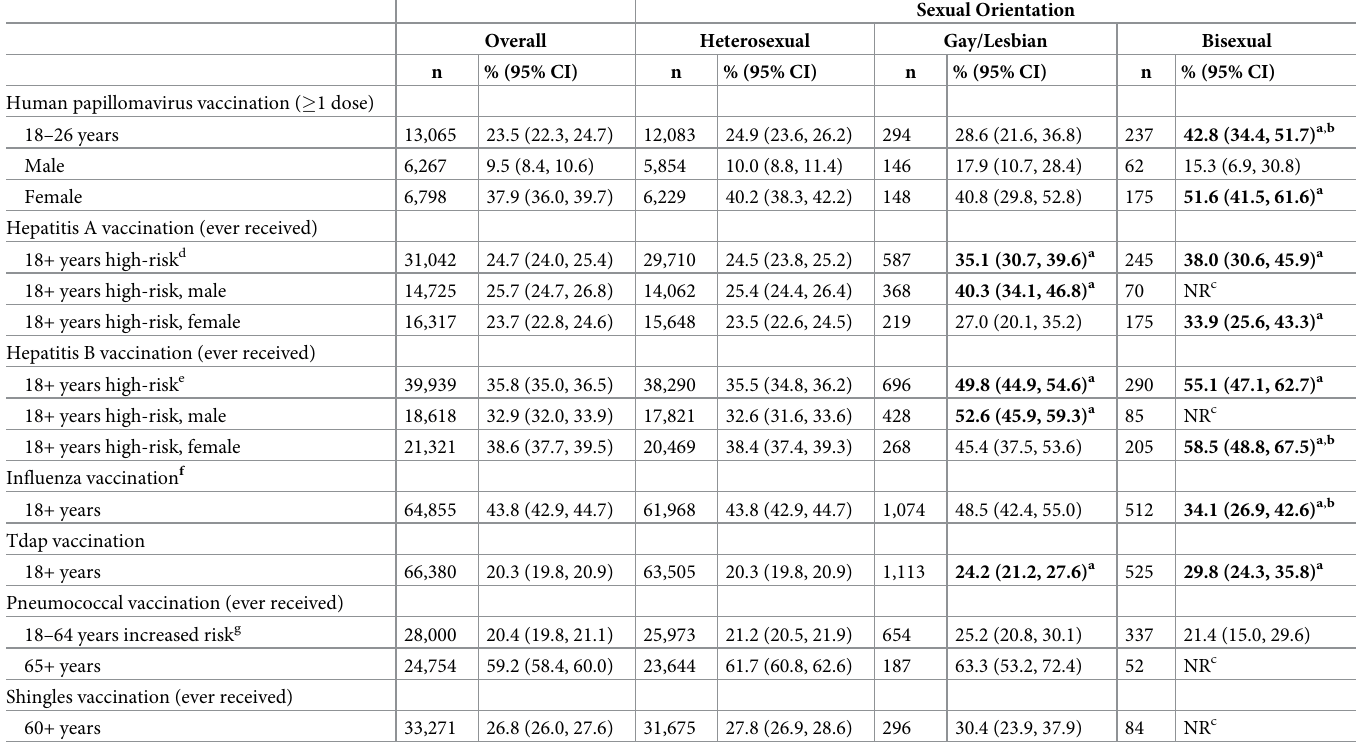
Table 2. Unadjusted vaccination coverage of selected vaccines among adults aged � 18 years in the United States by self-identified sexual orientation–National Health Interview Survey,